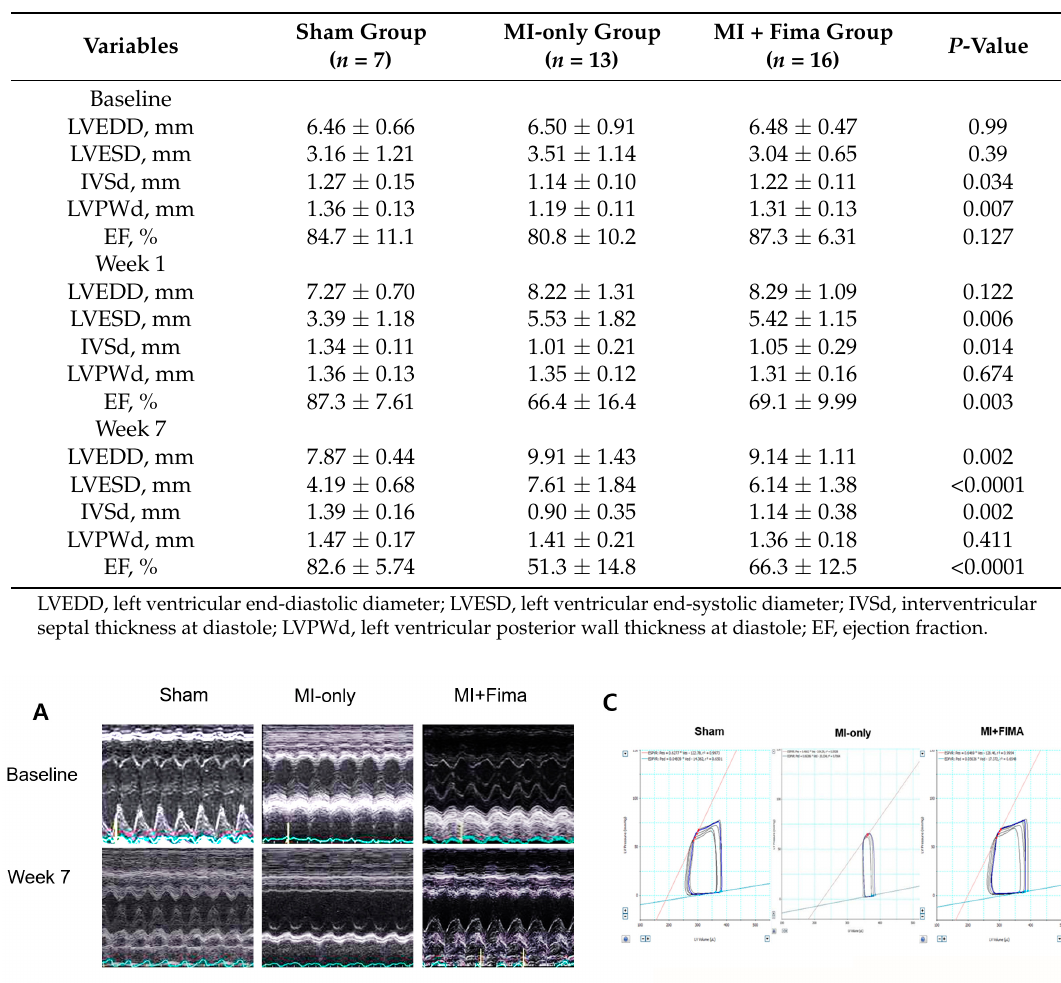
Table 1. The echocardiographic findings.